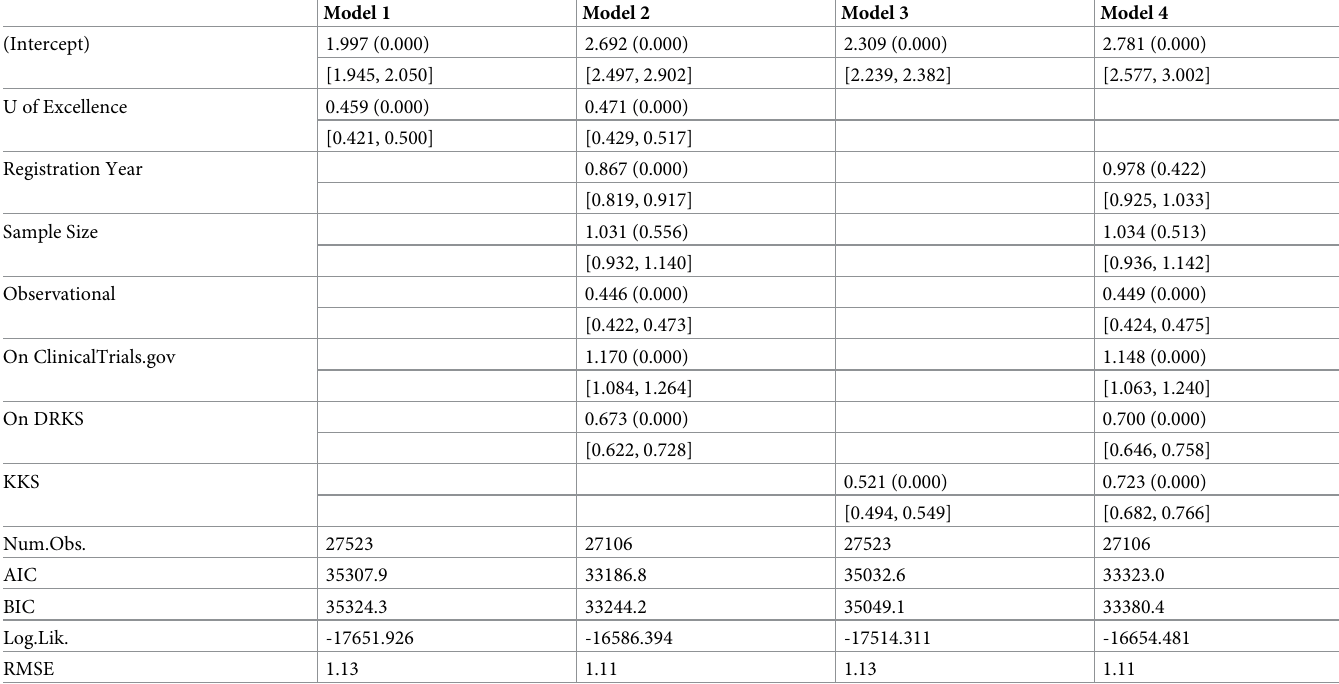
Table 4. Summary of logistic regression models of Odds-Ratios for Pre-Registration with p-values in parentheses and 95% confidence intervals. Model 1